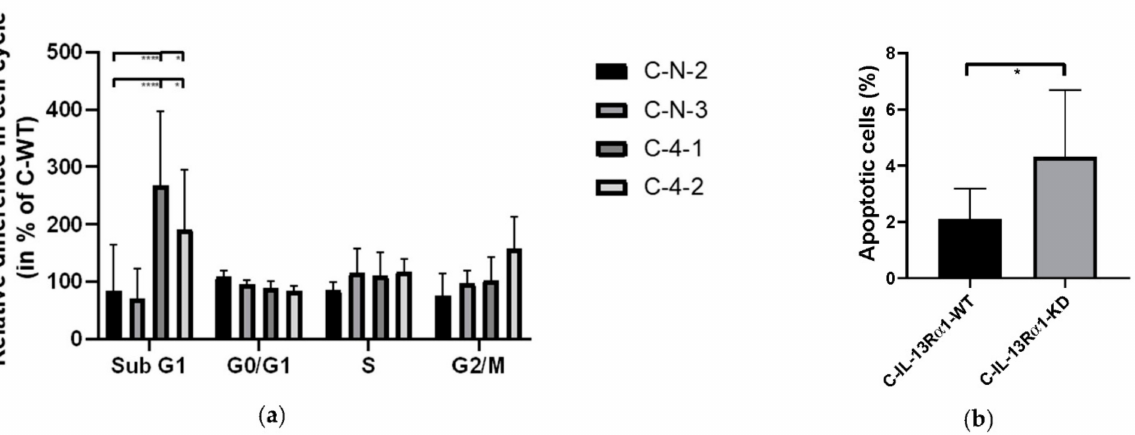
Figure 4. Cell cycle and apoptosis analysis. ( a ) Cell cycle analysis. Data acquired by Flow Cytometer and analysed by Flowjo are shown as relative difference of cell cycle fraction of C-N and C-KD clones in % ( ± SEM) compared to C-WT and are means of five independent experiments. The percentage of Sub G1 represents the fraction of cells in apoptosis. ( b ) Staining of Annexin V in Capan-1 cells indicates higher percentages of apoptotic cells after IL-13R α 1 knockdown. Results are shown as means of 3 independent experiments. (* p < 0.05, **** p < 0.0001).